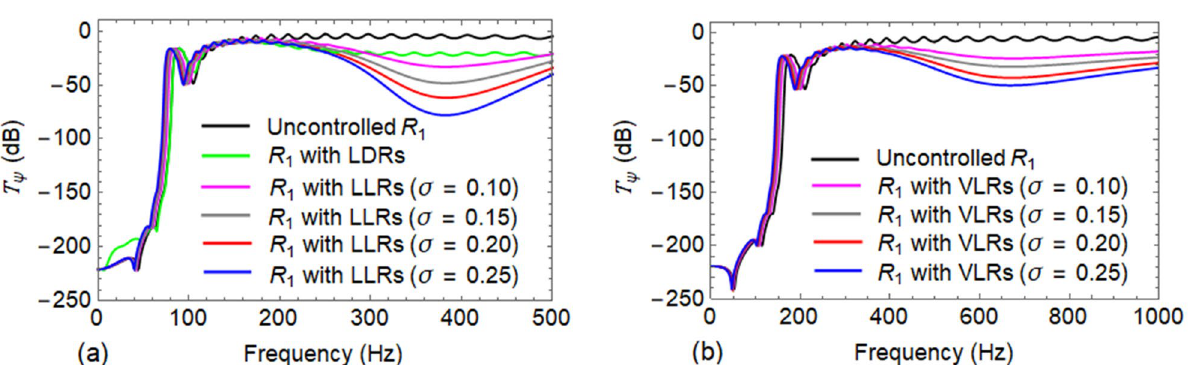
Figure 9. Comparison between transmittance T ψ ( dB ) of: ( a ) uncontrolled R 1 against R 1 with LDRs and LLRs in lateral direction; and ( b ) uncontrolled R 1 against R 1 with VLRs in vertical